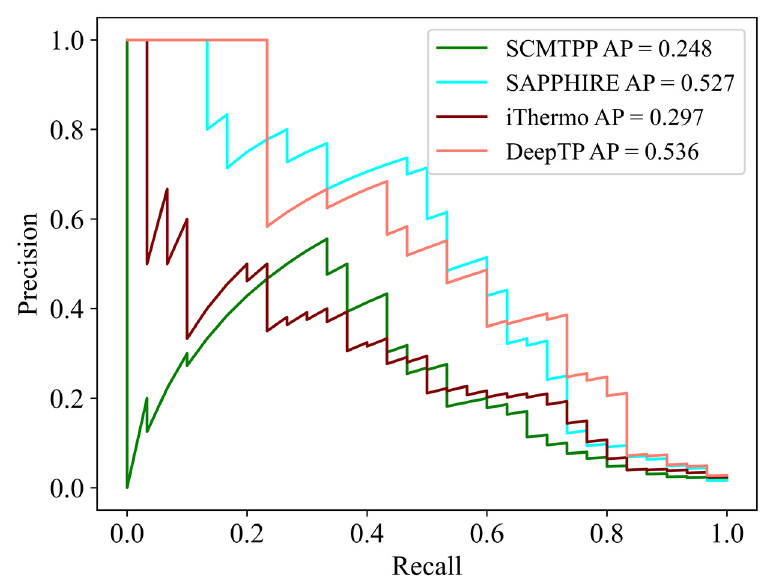
Figure 2. Precision-recall curves of tools in independent unbalanced test set.